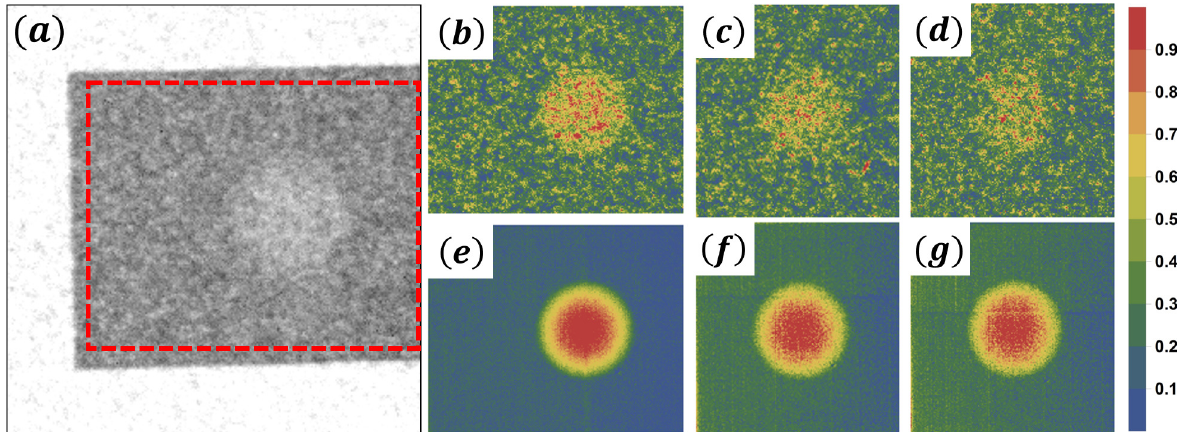
Figure 18. Static reference body: ( a ) an example radiograph; ( b – d ) normalized images cropped as in ( a ) for neutron flux transmission through the shorter axis, the longer axis, and the latter with an extra distance to the scintillator, respectively; ( e – g ) normalized mean luminance maps for the respective image sequences. Note the color bar to the